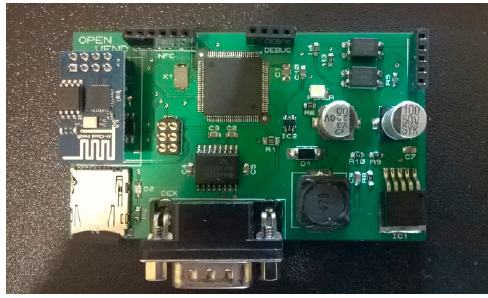
Figure 5. Arduino Mega compatible prototype.